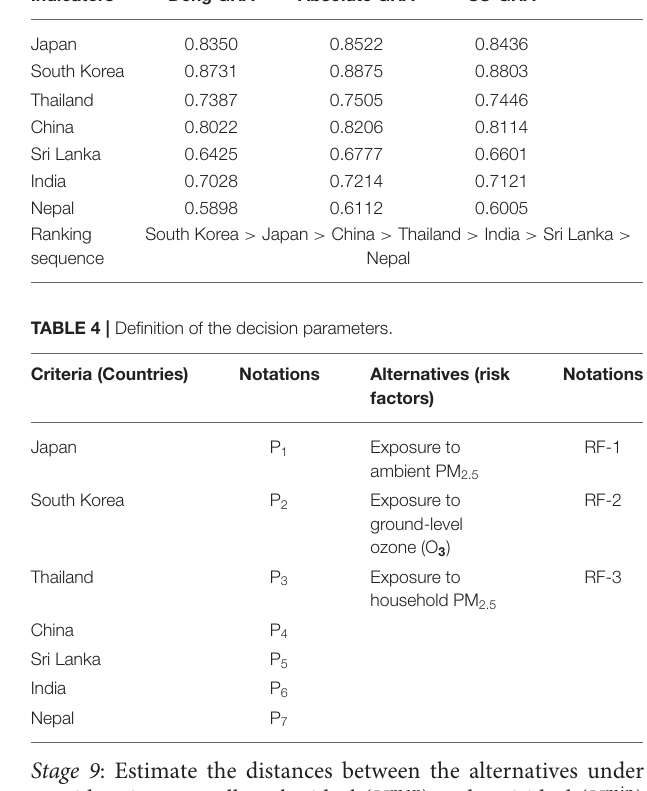
TABLE 1 | Grey assessment between ischemic heart disease (IHD) mortality and exposure to household PM 2.5 . Indicators